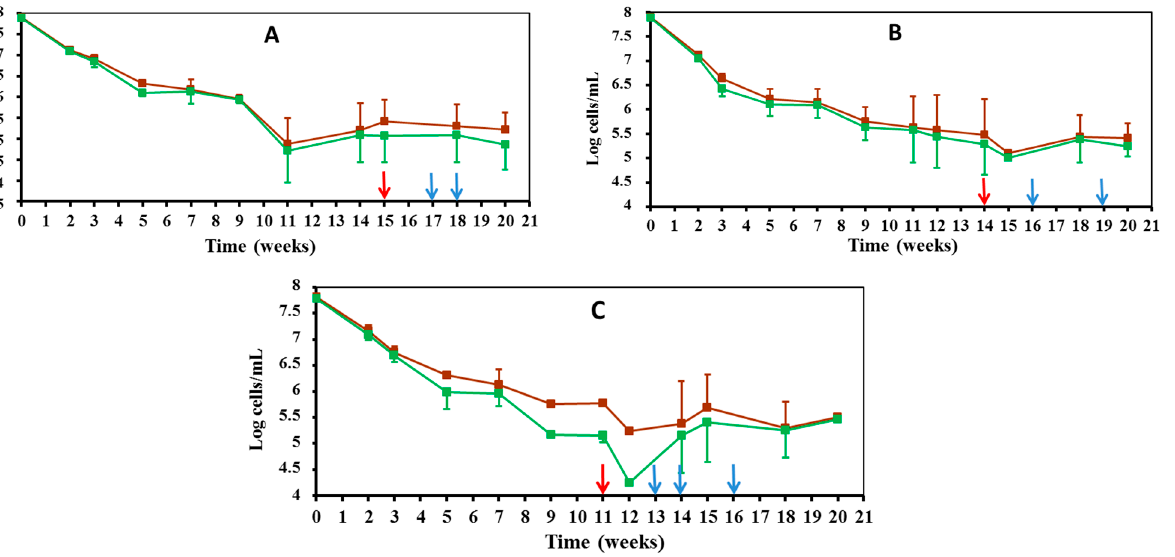
Figure 3. Direct counts of total (brown line) and viable (green line) Edwardsiella cells maintained under starvation conditions in FSLW microcosms at 25 °C: ( A ) E. piscicida V12.1; ( B ) E. piscicida V57.2; ( C ) E. tarda V43.2. Red arrow indicates the beginning of the VBNC period. Blue arrows indicate the timing of resuscitation experiments of VBNC Edwardsiella cells.